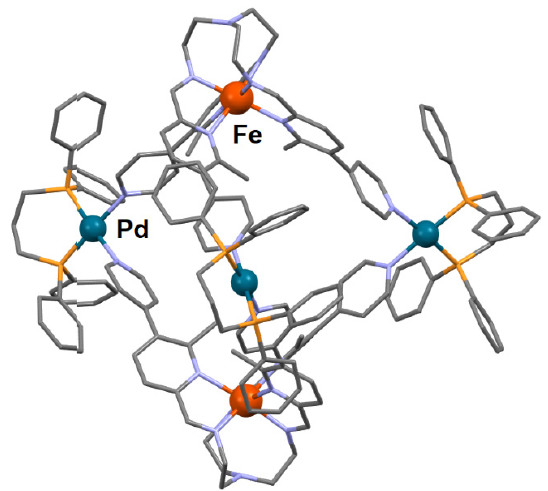
Figure 6. Crystal structure of the trigonal bipyramidal [Fe 2 Pd 3 ] 10+ cage. Hydrogen atoms, tetraborate anions and solvent molecules are not shown [110].